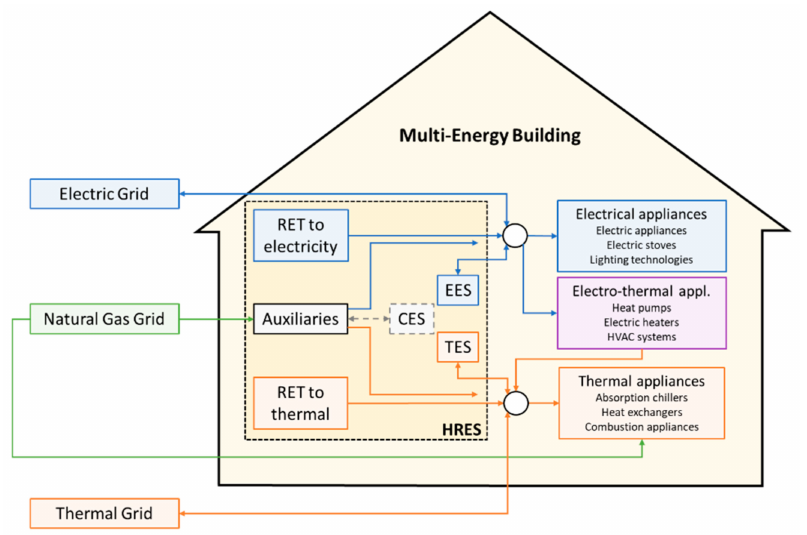
Figure 4. Energy flows and balances of a multi-energy building with HRES. The energy balance of the residential building is described with reference to thermal and electrical energy outflows. The thermal energy balance refers to outflows (in orange): 1.